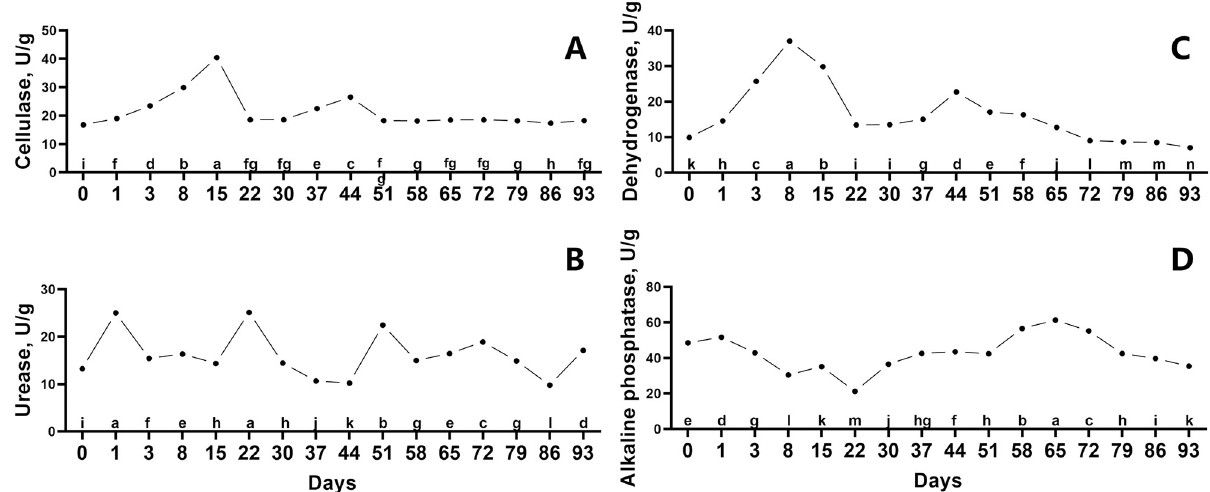
Fig 3. Changes of enzymatic activities in ectopic fermentation bed. Cellulase (A), urease (B), dehydrogenase (C) and alkaline phosphatase (D) were determined during the EFS process. Statistical assessment was carried out with one-way ANOVA followed by post hoc test using Dunn’s multiple comparison test. Values with different letters are significantly different at P <